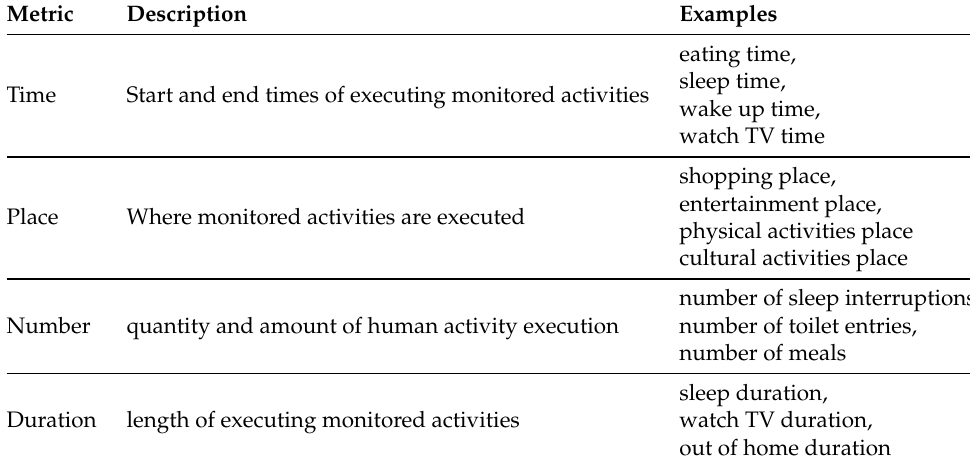
Table 5. Metrics for measures’